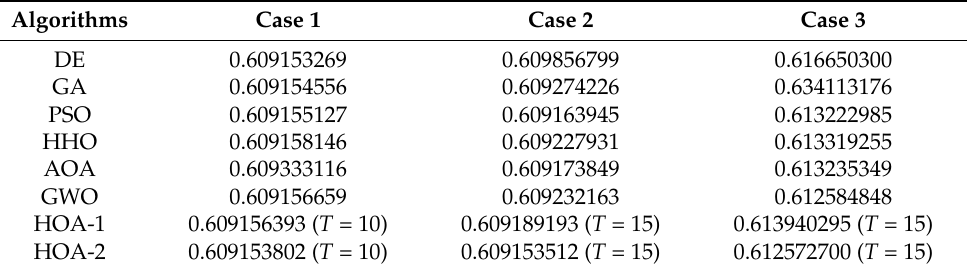
Table 7. Results of three